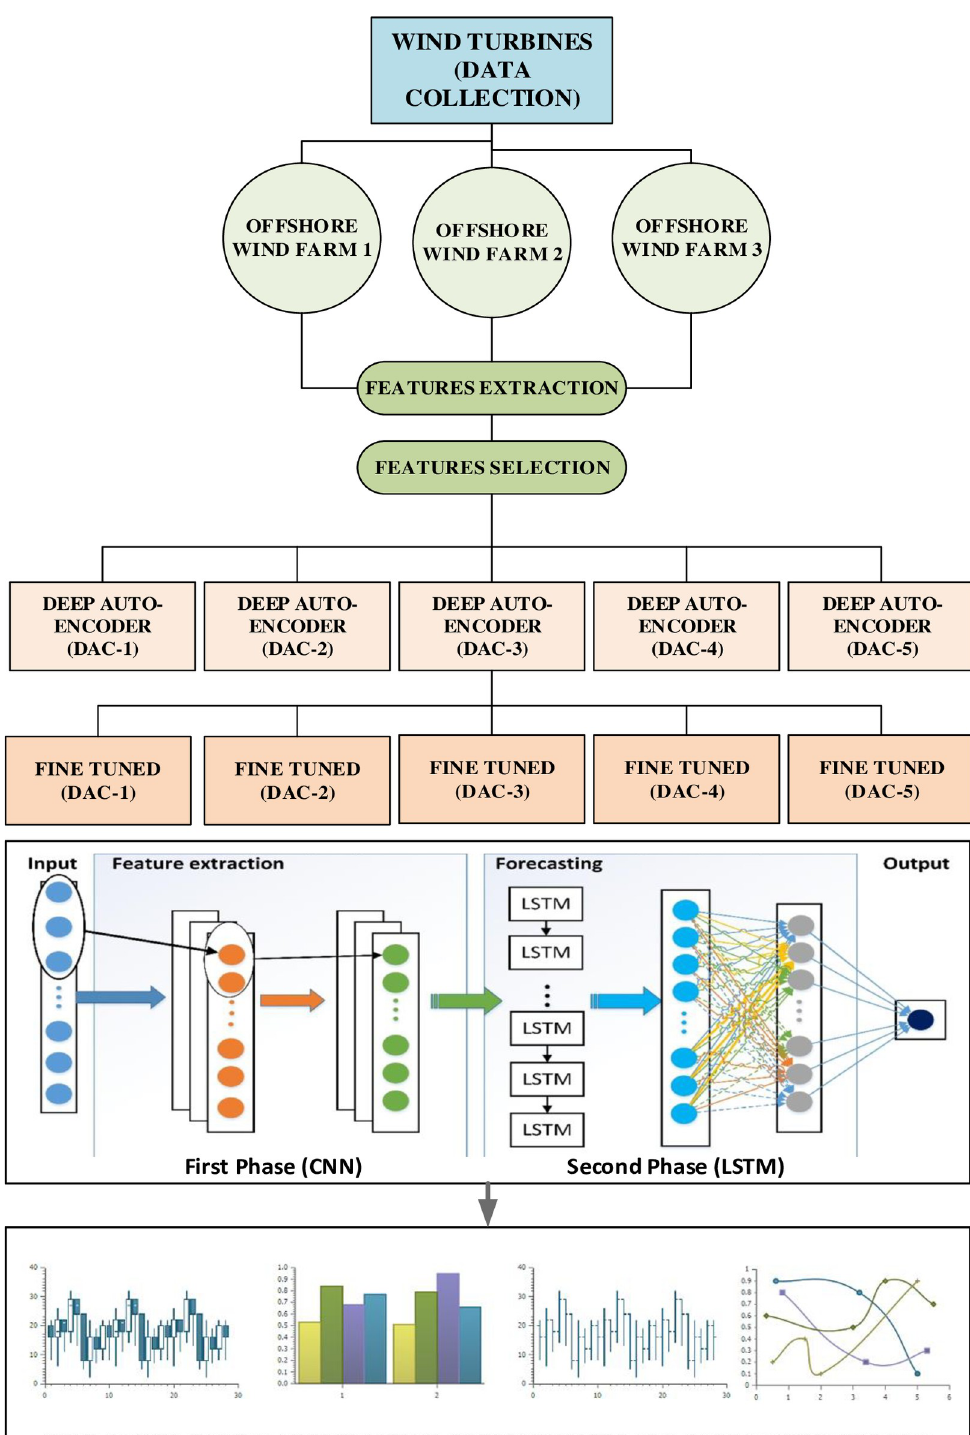
Fig 1. Overall methodology and overview of offshore wind power forecasting